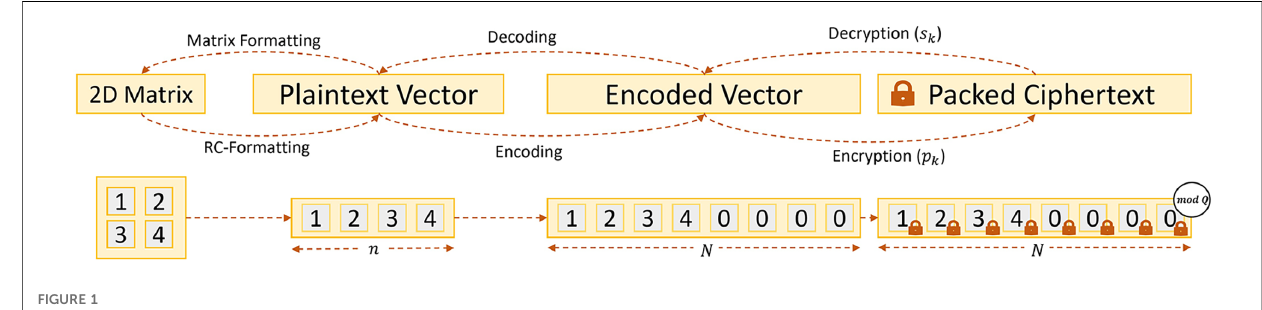
FIGURE 1 Encryption procedure for Homomorphic Encryption Schemes based on Learning with Errors